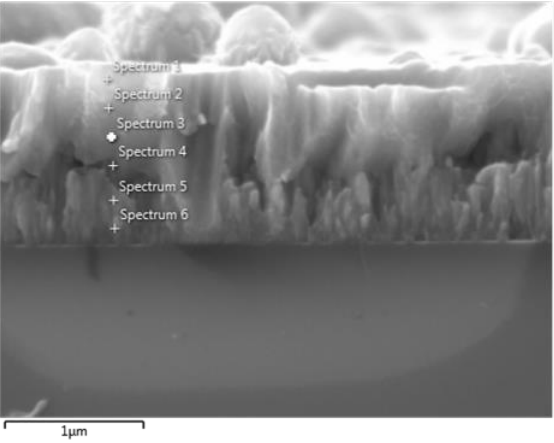
Figure 5. Micrograph showing the location of the EDS spectra from 1 to 6 in the TiO x coating deposited using a 300/100 Ar/O 2 flow ratio.